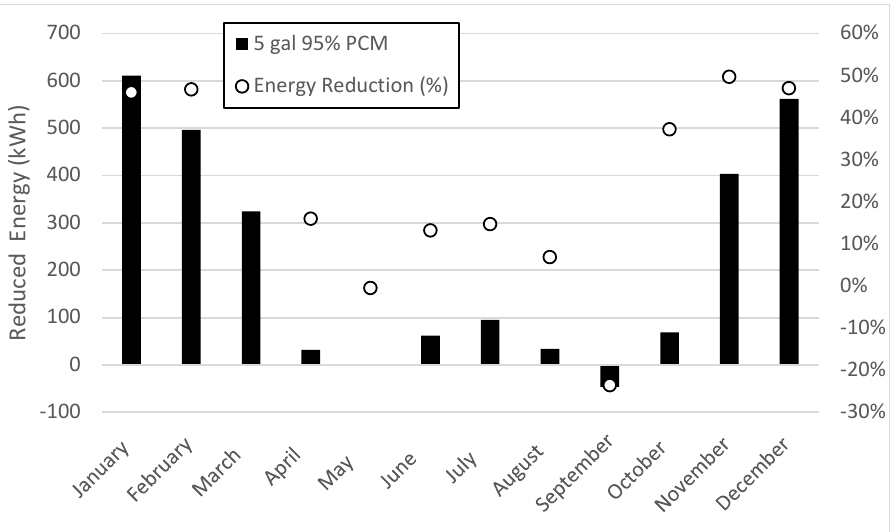
Figure 8. Energy Reduction.